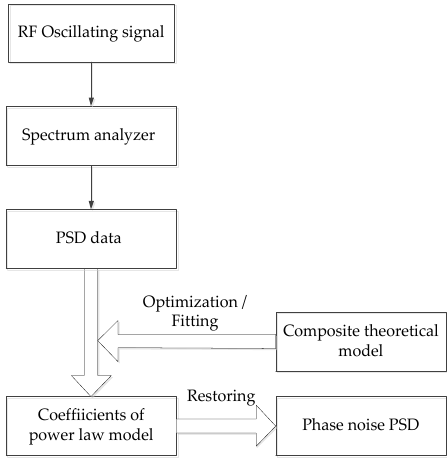
Figure 1. Schematic of phase noise measurement modality.